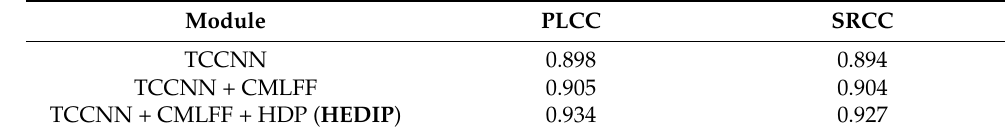
Table 6. Ablation results on the MCL-3D database. The HEDIP is the model proposed in this paper.